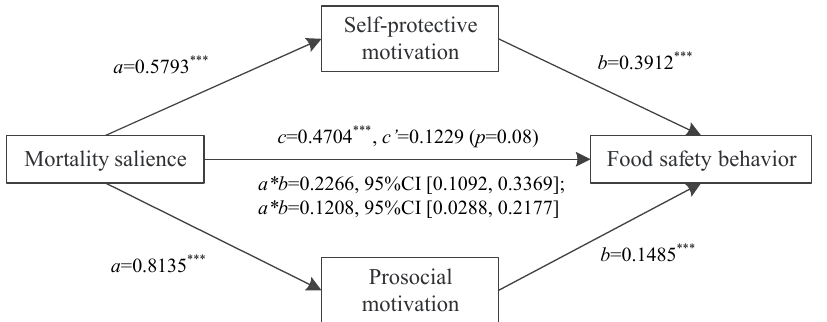
Figure 2. Mediating analysis of self-protective motivation and prosocial motivation. Note: p -value < 0.001, “***”; p -value < 0.01, “**”; p -value < 0.05, “*”.